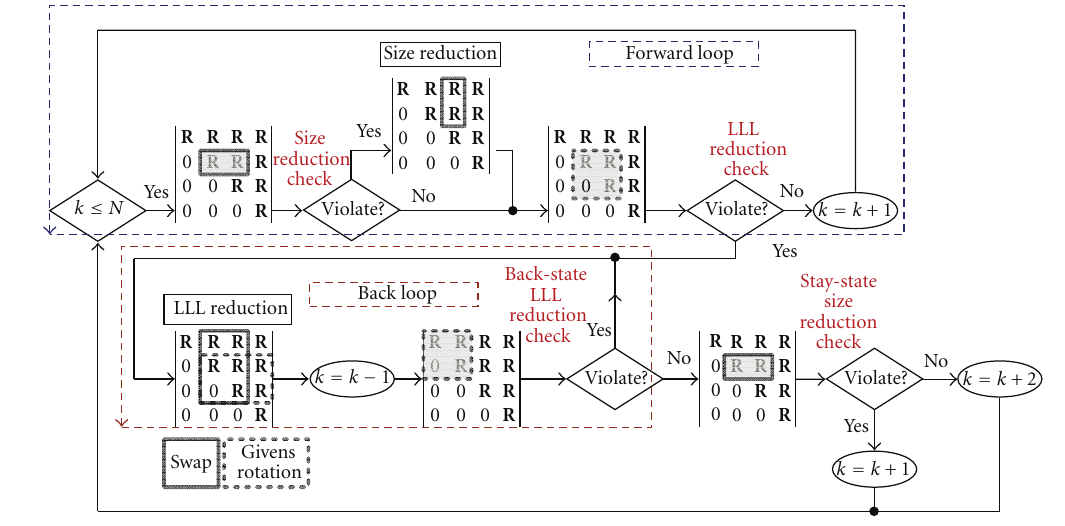
Figure 1: The flow chart for loop-reduction LLL algorithm.